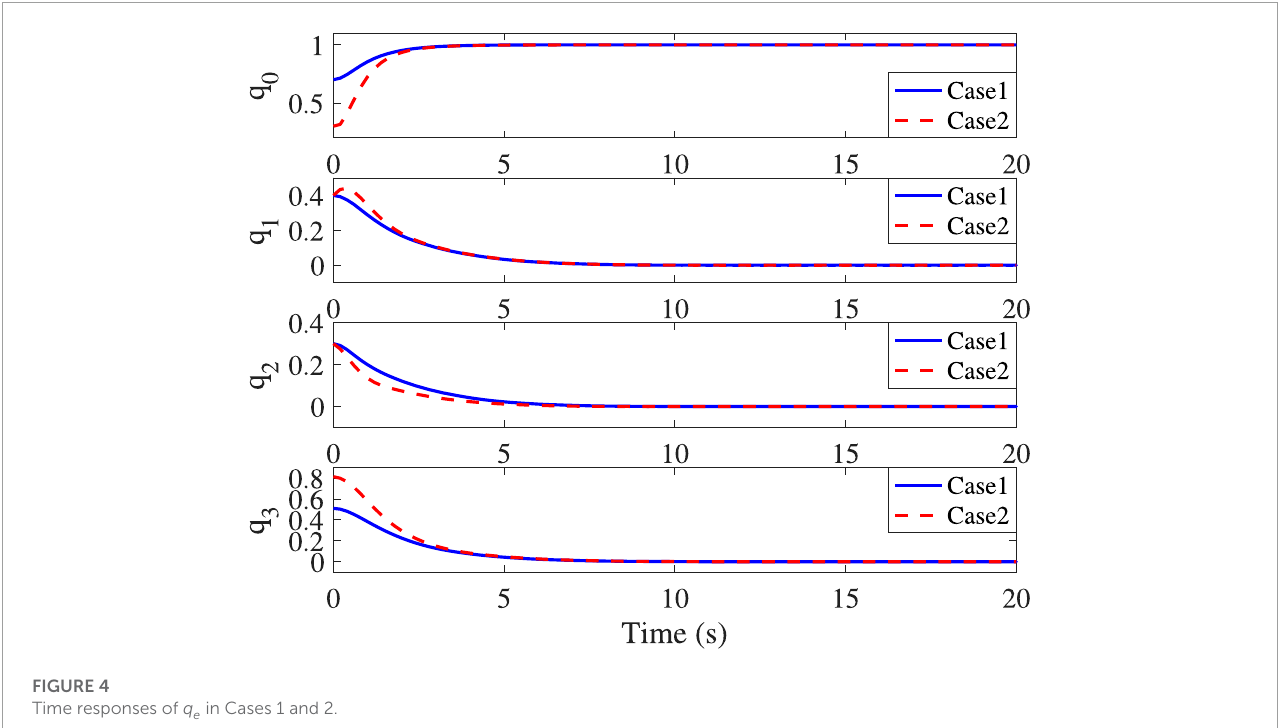
FIGURE 4 Time responses of q e in Cases 1 and 2.